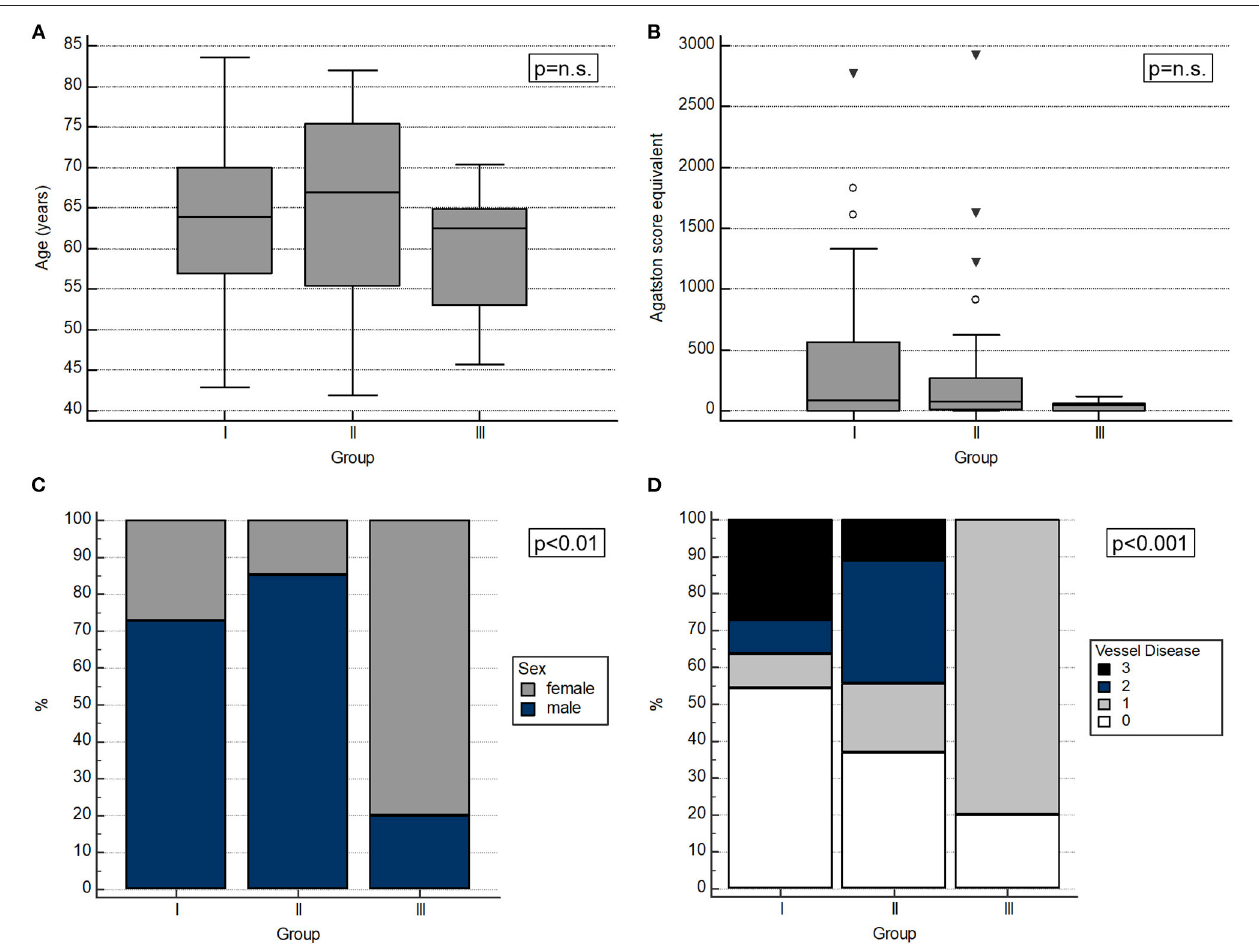
FIGURE 2 | Characteristics of the CAD progression groups. (A) Age did not differ significantly between groups. (B) The initial Agatston score equivalent showed no significant differences between groups. (C) The sex distribution was significantly different between groups with the regression group showing the highest fraction of female patients. (D) Patients of the regression group showed solely mild or one-vessel CAD. Of note, the fraction of stenotic coronary arteries differed significantly between groups at the initial